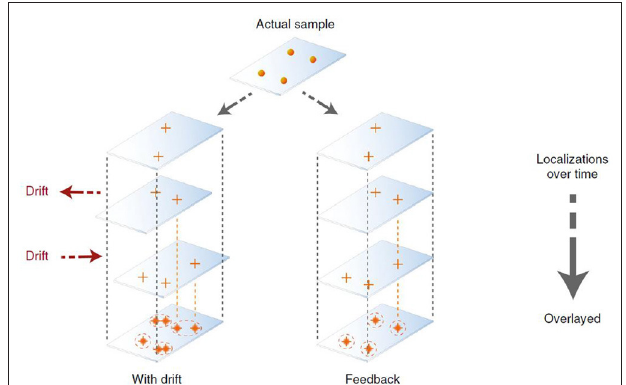
FIGURE 4 | Measurement of single molecular binding kinetics with PAINT. Initially developed as an imaging tool, PAINT has been established as a method to measure binding affinities between biomolecules including DNA, peptides, and small molecular drug targets. Shown above as an example of measuring dissociation constant between cocaine and single stranded DNA split aptamer (Morris et al., 2018). Copyright with permission from the American Chemical